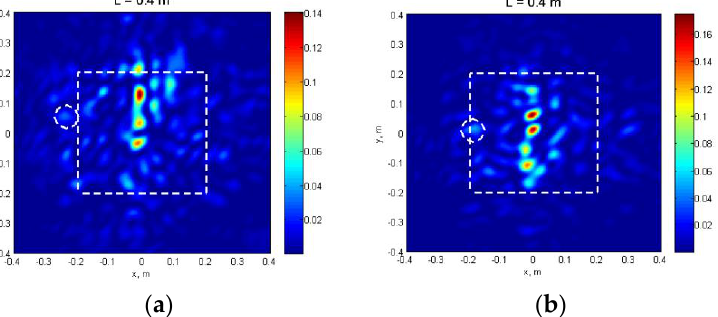
Figure 19. Image of the metal rod, focused in object plane z = 0.4 m. Radiator height ( a ): h = 0.1 m; ( b ): h = − 0.05